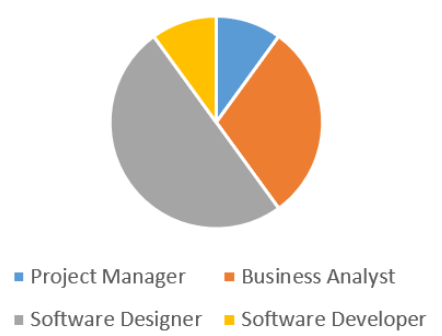
Figure 12. Effort distribution for different roles (E-MDAV case).